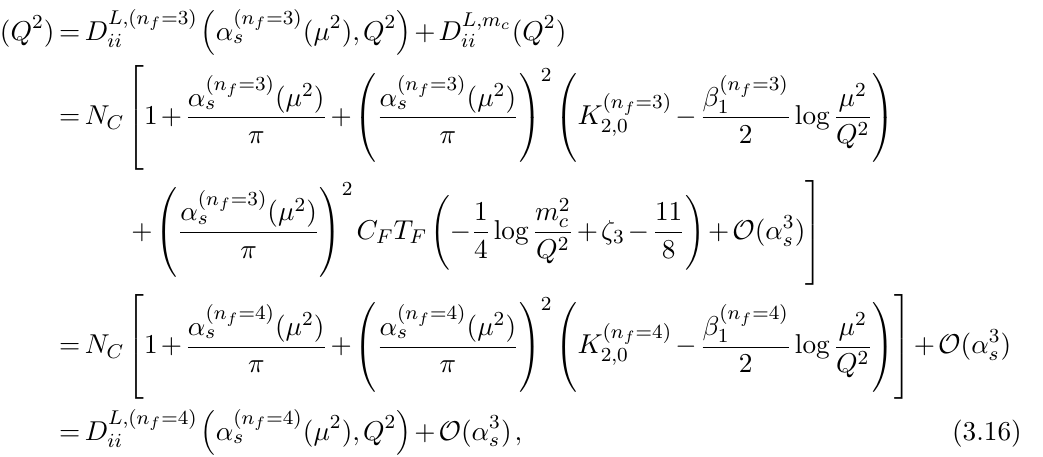
/s < 1 . Right: comparison between c afterwards. The input value α ( n f =5) s ( M 2 ) = 0 . 1184 c Z